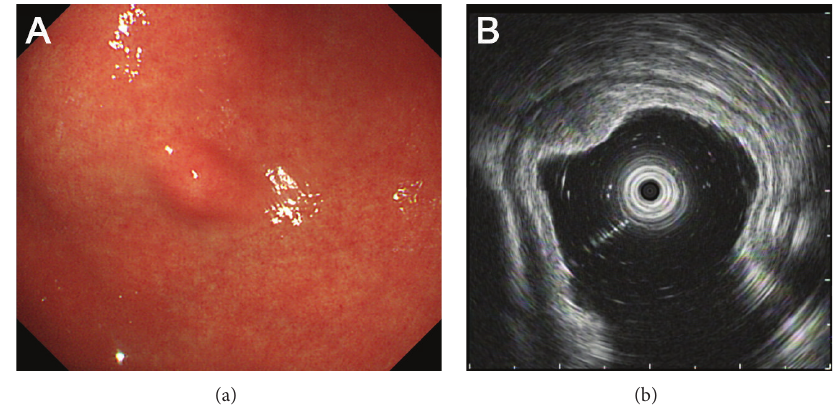
Figure 1: Endoscopic images. Esophagogastroduodenoscopy revealed a submucosal tumor with a diameter of approximately 10mm in the greater curvature of the gastric antrum (a). Endoscopic ultrasonography showed a solid tumor with hypoechoic internal echogenicity measuring 11.8mm, which was located in the deep mucosal and submucosal layers (b). Anechoic duct-like structure was not detected in the